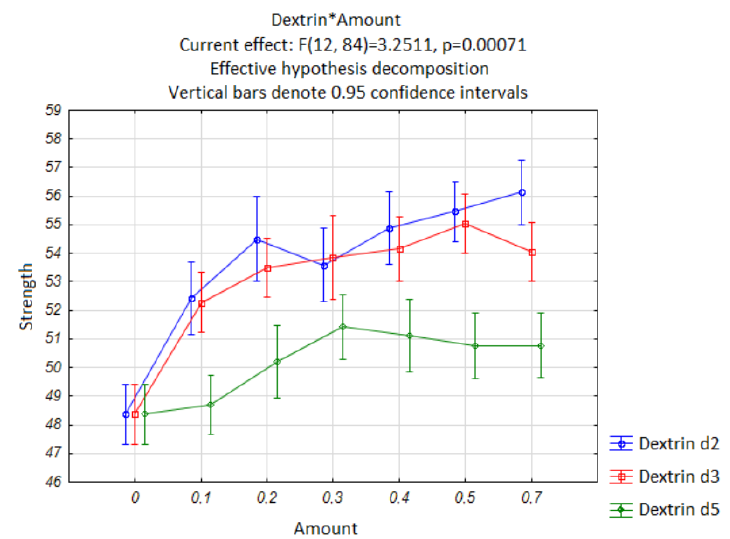
Figure 9. Confidence interval analysis.